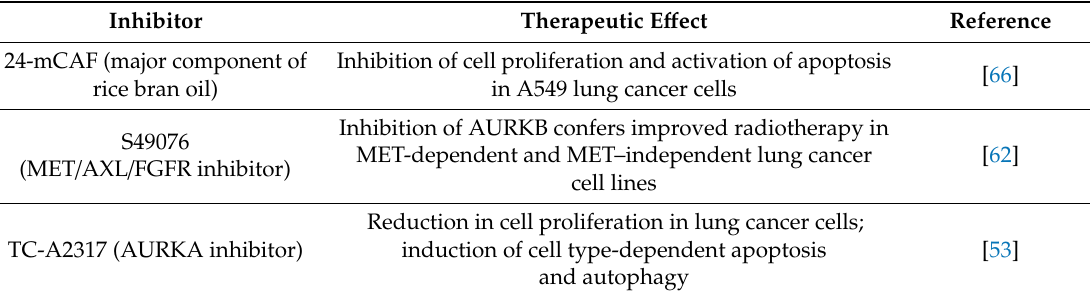
Table 3. E ff ects of specific inhibition of AURKA and / or AURKB in lung